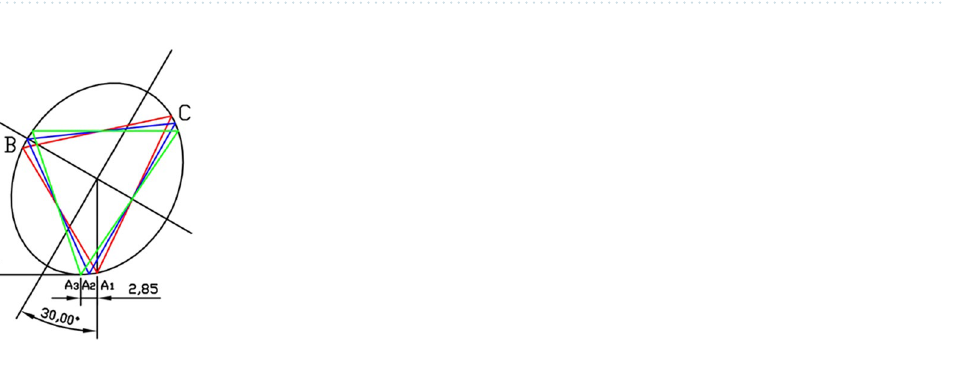
Figure 4. When the femoral calcar screw was located at different positions, with the clockwise change of point A, the trend of the area and circumference ratio of OT, IET, and MA-IIT in the ellipse.